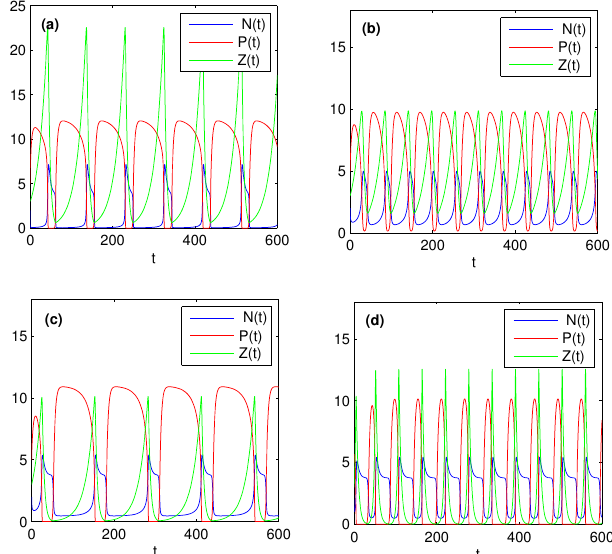
Figure 3. Effects of nonlinear uptake and grazing functions on the population persistence in de- terministic environment. Here, we take a = 2, c = 0.5, µ 1 = 0.1, µ 2 = 0.2, µ 3 = 0.1, µ 4 = 0.2, D = 1, D 1 = 0.3, D 2 = 0, N 0 = 3.75. ( a ) k = 0.2, λ = 0.5, δ = 0.5; ( b ) k = 1.8, λ = 0.5, δ =